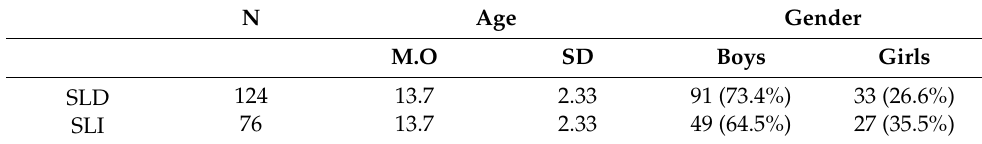
Table 1. Demographic